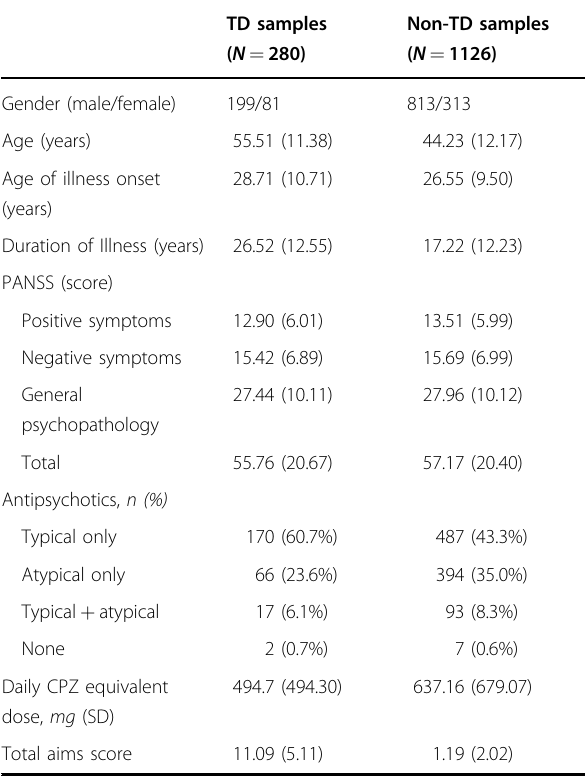
Table 1 Characteristics of tardive dyskinesia versus non- tardive dyskinesia